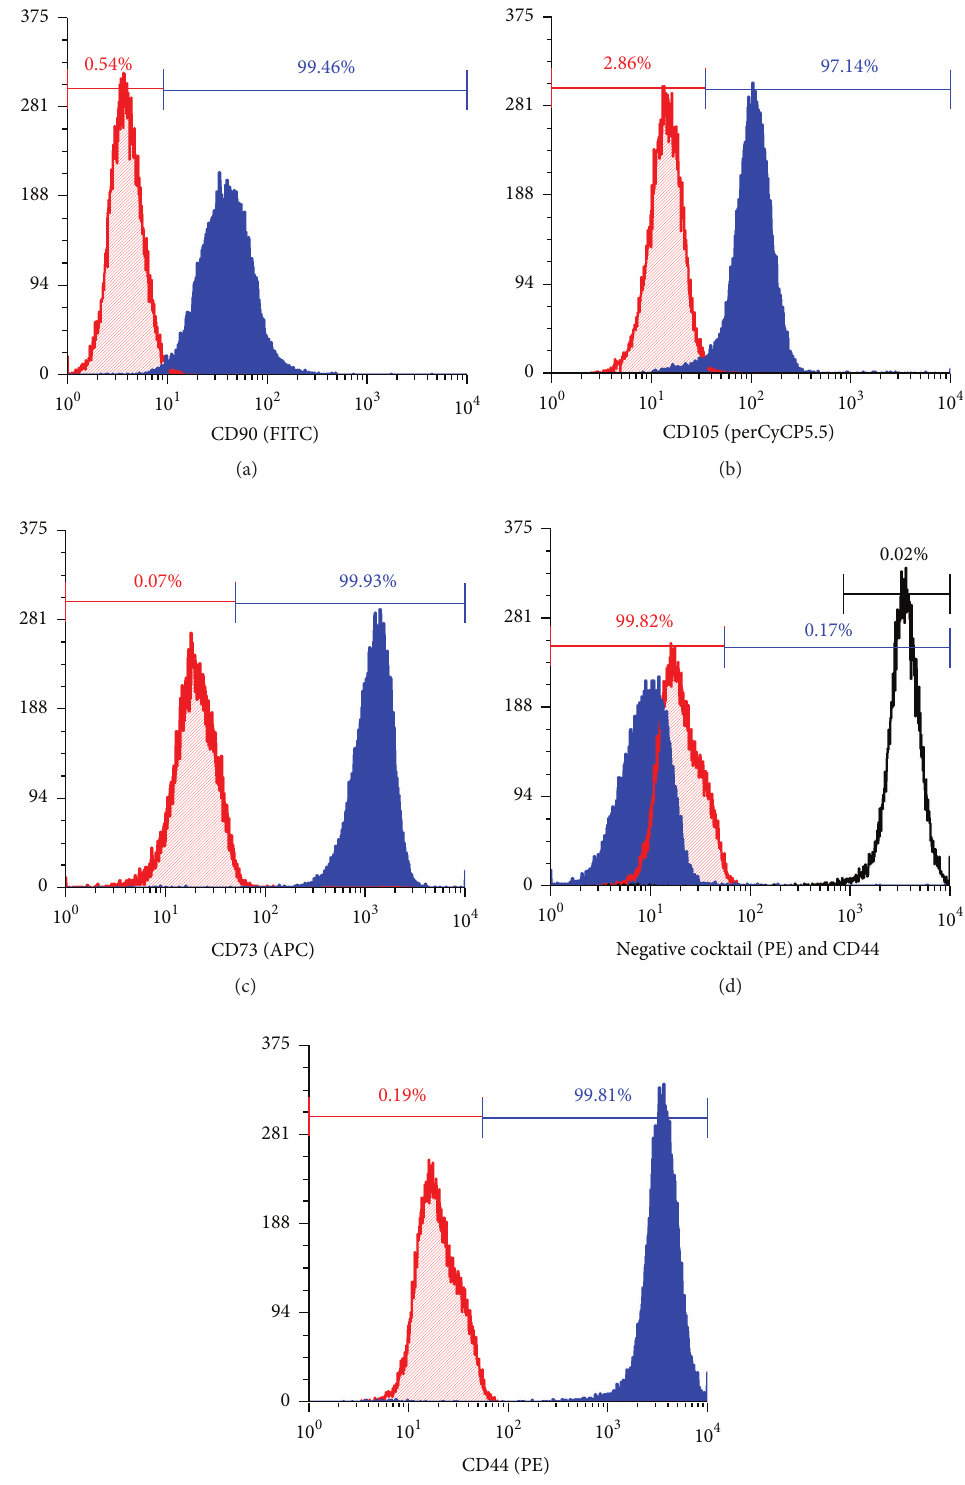
Figure 5: Histograms of flow cytometry; blue solid filled overlay represents the test sample; red diagonal line filled overlay represents the isotype control. For each histogram the negative gate (red bar) was set for inclusion of 99% of the isotype. Percentages shown in histograms are for the test samples. (a–c) All are markers in the positive cocktail, CD90, CD105, and CD73. The positive gate percentages shown in blue for each sample. (d) The negative cocktail, with CD44 included as a positive control (unfilled overlay) positive percentage in black. (e) CD44 marker included outside of the positive